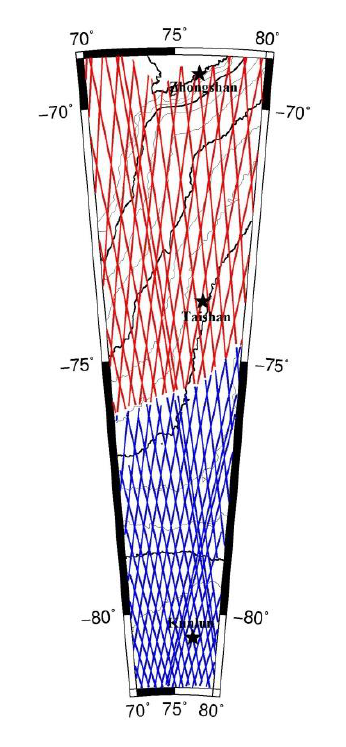
Figure 3. Ground tracks for CryoSat-2 over the transect from Zhongshan Station to Dome A, the blue lines indicate the LRM tracks, while the red lines indicate the SARIn